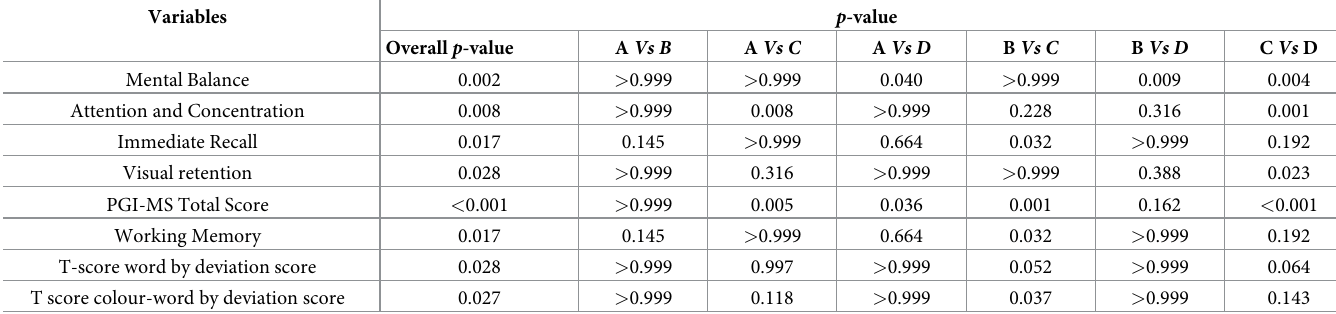
Table 2. Intervention effects across